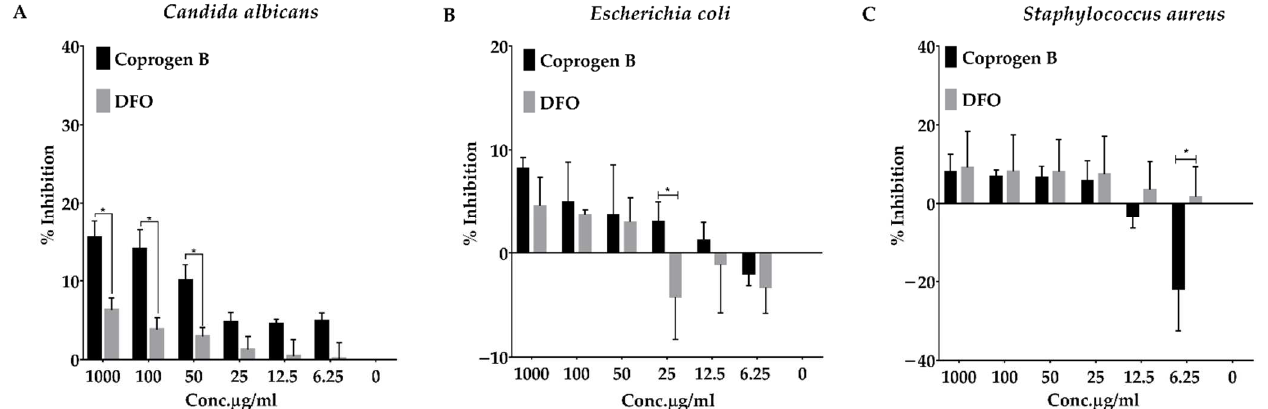
Figure 11. Effect of coprogen B and deferoxamine on growth of Candida albicans ( A ), Escherichia coli ( B ), and Staphylococcus aureus ( C ). The level of growth in each well was quantified by absorbance at 570 and 600 nm. Then, the percentage of inhibition was calculated from the percentage reduction of resazurin dye. Data are expressed as mean ± SD. Asterisk (*) indicates significant difference, p -value < 0.05.